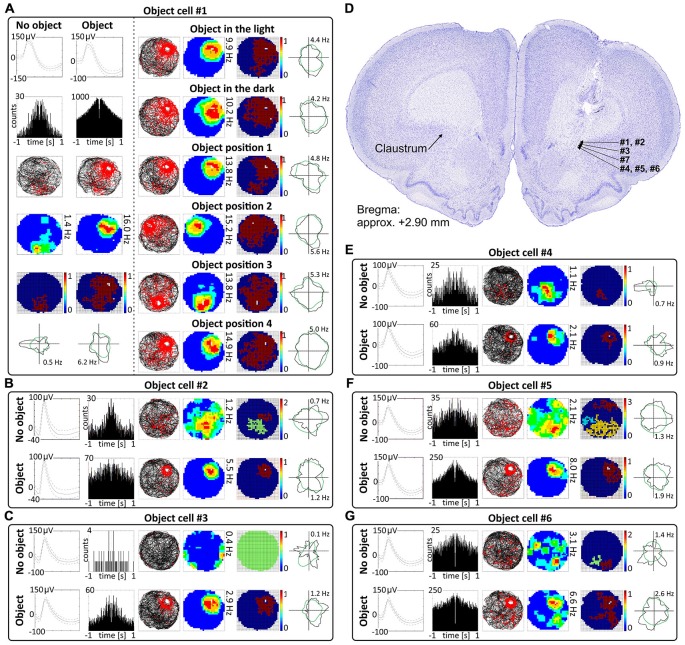
Object cells in rat anterior claustrum. (A) Claustral object cells responded to the presentation of an object (glass bottle) with increased firing activity; a firing field was created in the proximity to the object. The visual cue was located in the same place as in Figure 1 in baseline conditions. (A) On the left, two consecutive recording sessions of an object cell with and without presentation of the object. For each recording session presented in columns are: spike waveform; autocorrelation ± 1000 ms; path of the animal recorded during 20 min session with superimposed firing activity; firing intensity map with maximum firing frequency; place map and polar plot. (A) On the right, recordings performed in the light, darkness and after changes of object’s position during consecutive recording sessions in the light. For each session in rows are shown: path of the animal; firing intensity map; place map and polar plot. (B,C,E–G) Examples of other object cells recorded in anterior claustrum. Recording sessions were performed in the light with and without presentation of the object. Cells expressed varied spontaneous firing rates and varied increases in firing activity in response to the object (e.g., cell #1 vs. cell #3). For each session, in rows, are shown: spike waveform; autocorrelation ± 1000 ms; path of the animal with superimposed firing activity; firing intensity map; place map and polar plot. (D) Estimated location of object cells presented in this figure reconstructed on a representative histological specimen.